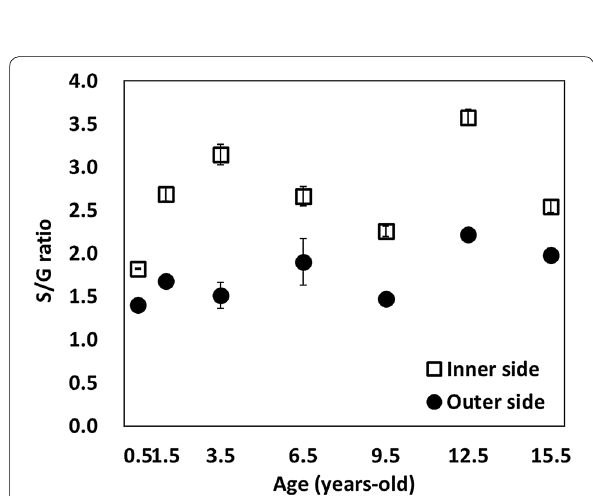
Fig. 7 Ratio of S/G thioacidolysis monomers obtained from bamboo